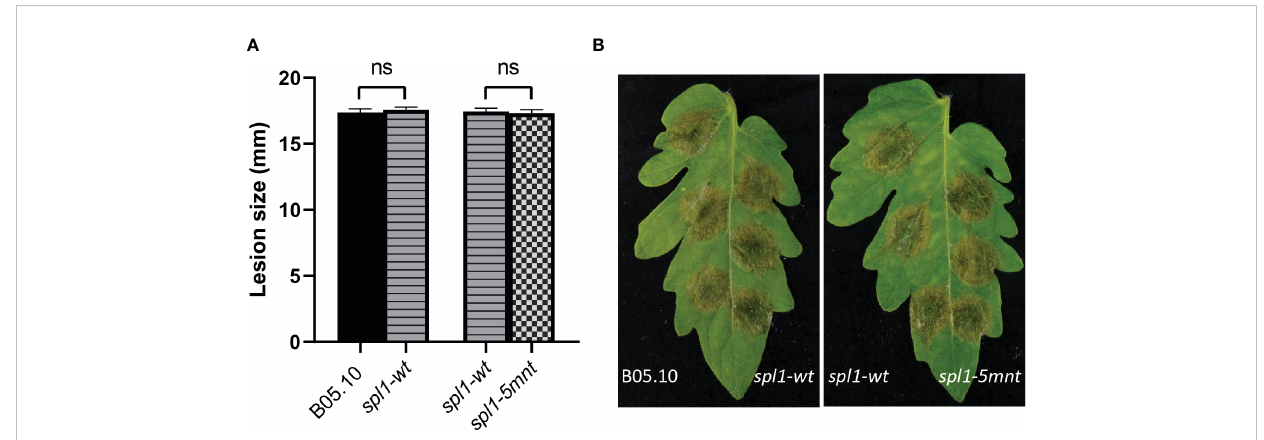
FIGURE 5 Virulence of B . cinerea WT B05.10 , spl1-wt and spl1-5mnt transformants on tomato leaf, represented by a bar chart (A) ; and disease symptoms photographed at 3 dpi (B) . The average lesion sizes and standard errors in the bar chart (A) resulted from 92 inoculations in three independent experiments, and statistical analysis was performed using t-test (ns indicates non-signi fi